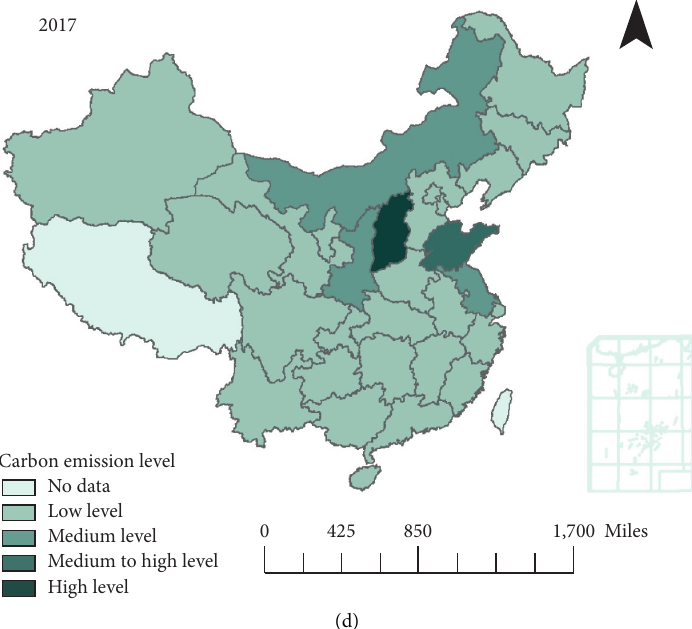
Figure 2: Evolution of carbon emission intensity in China by province. Figure 2 only contains carbon emission data for each province in mainland China, not including data for Hong Kong, Macau, Taiwan, and the South China Sea under Chinese territory. Table 1: List of three batches of low-carbon pilot cities. List of pilot provinces and